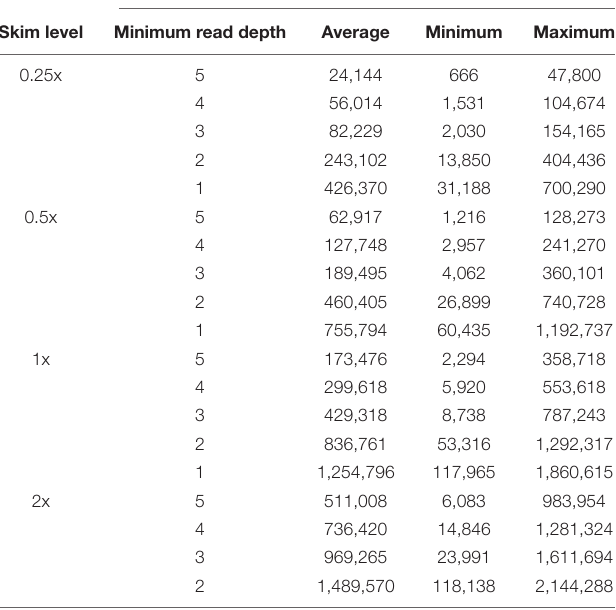
TABLE 4 | The average, minimum, and maximum number of SNPs genotyped in individuals in the DH samples for each sequencing coverage level and filtering